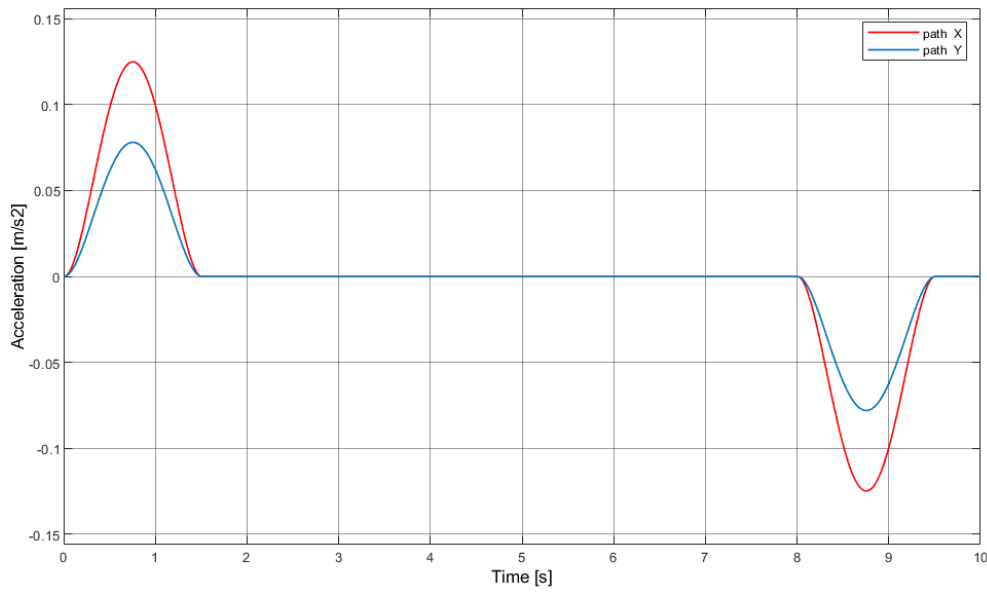
Figure 6. Trajectory for acceleration using 6-1-6 polynomials for the planar CDPR.